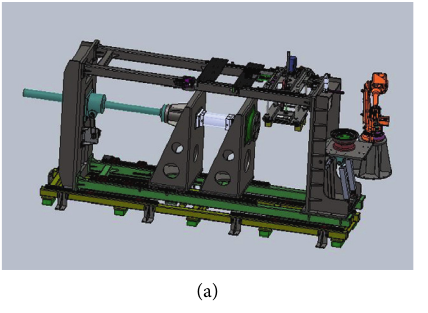
Figure 3: The capping press process. Table 2: Customer demands for a control service system.